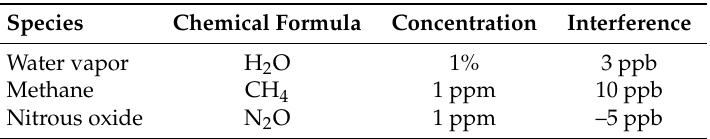
Table 2 quantifies contributions from the different gases to the CF 4 measurement. Despite the close proximity of interfering absorption lines, the influence on the CF 4 measurement is limited for typical emission gas mixtures in the aluminum industry. Table 2. Overview of interference at a gas temperature of 125 ◦ C.